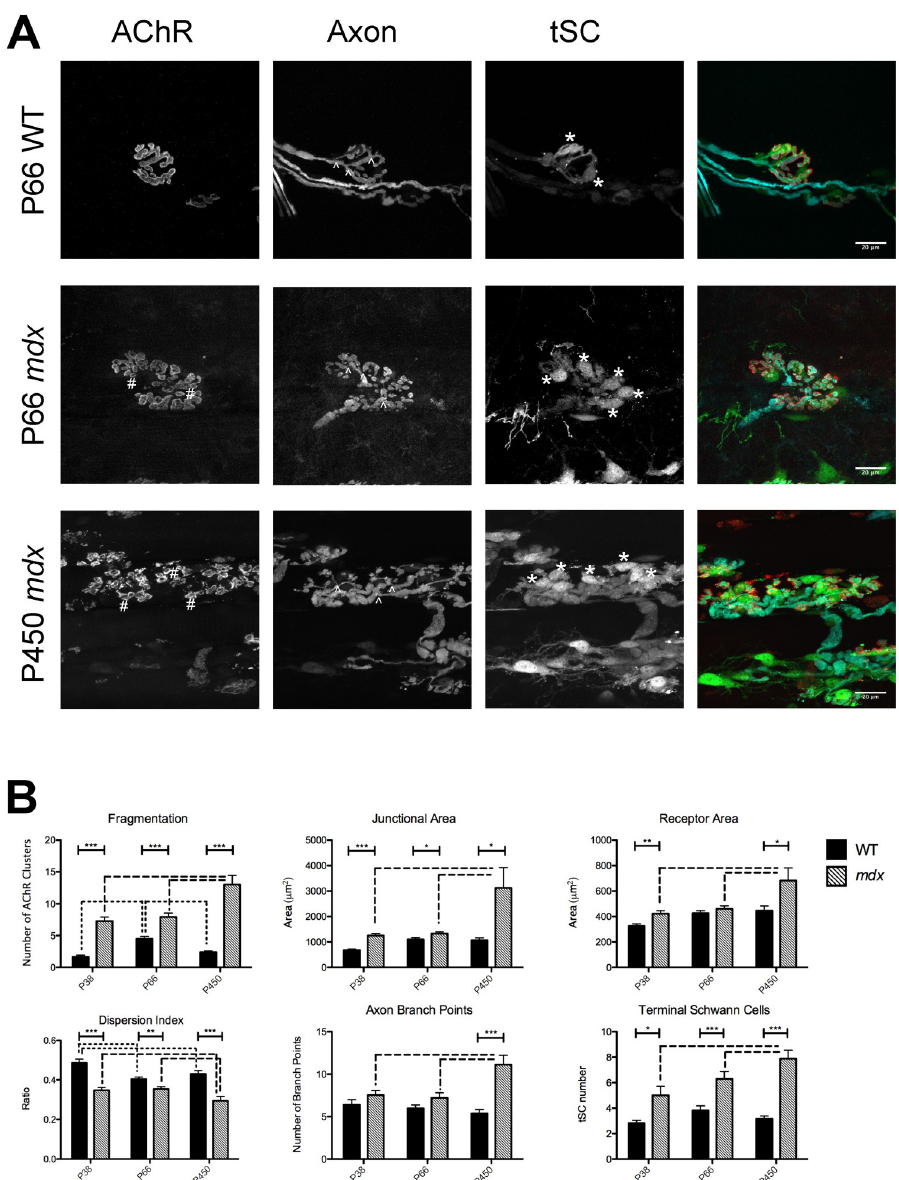
Fig 1. WT and mdx NMJs. (A) Maximum intensity projection confocal images of P66 WT, P66 mdx and P450 mdx NMJs. Images from left to right: AChR, motor axon terminal arbor, tSCs, and composite images. In the composite image, AChRs are pseudocolored red, motor axons cyan, and tSCs green. Scale bar = 20 μ m. “#” indicates examples of AChR fragments; arrowheads, examples of axon terminal branch points; asterisks cell bodies of tSCs. In P450 mdx , not all tSCs are marked. Some non-specific labeling via the S100 promoter of cells that cannot be positively identified as Schwann cells is seen. These cells are not labeled as tSCs in the panels nor included in measurements. (B) Junctional measurements in WT and mdx NMJs from P38 to P450 as described in “Image acquisition and analysis”. Asterisks above solid bars denote significance between genotypes (t-test, � P < 0.05, �� P < 0.001, ��� P < 0.0001). 15 to 90 NMJs were compared for each measurement. Exact n can be found in text as t(df) = t-value. n = df + 2. n is pooled number of individual NMJs compared. Dashed lines denote significance between ages (2-Way ANOVA, Bonferroni post-hoc test, P <